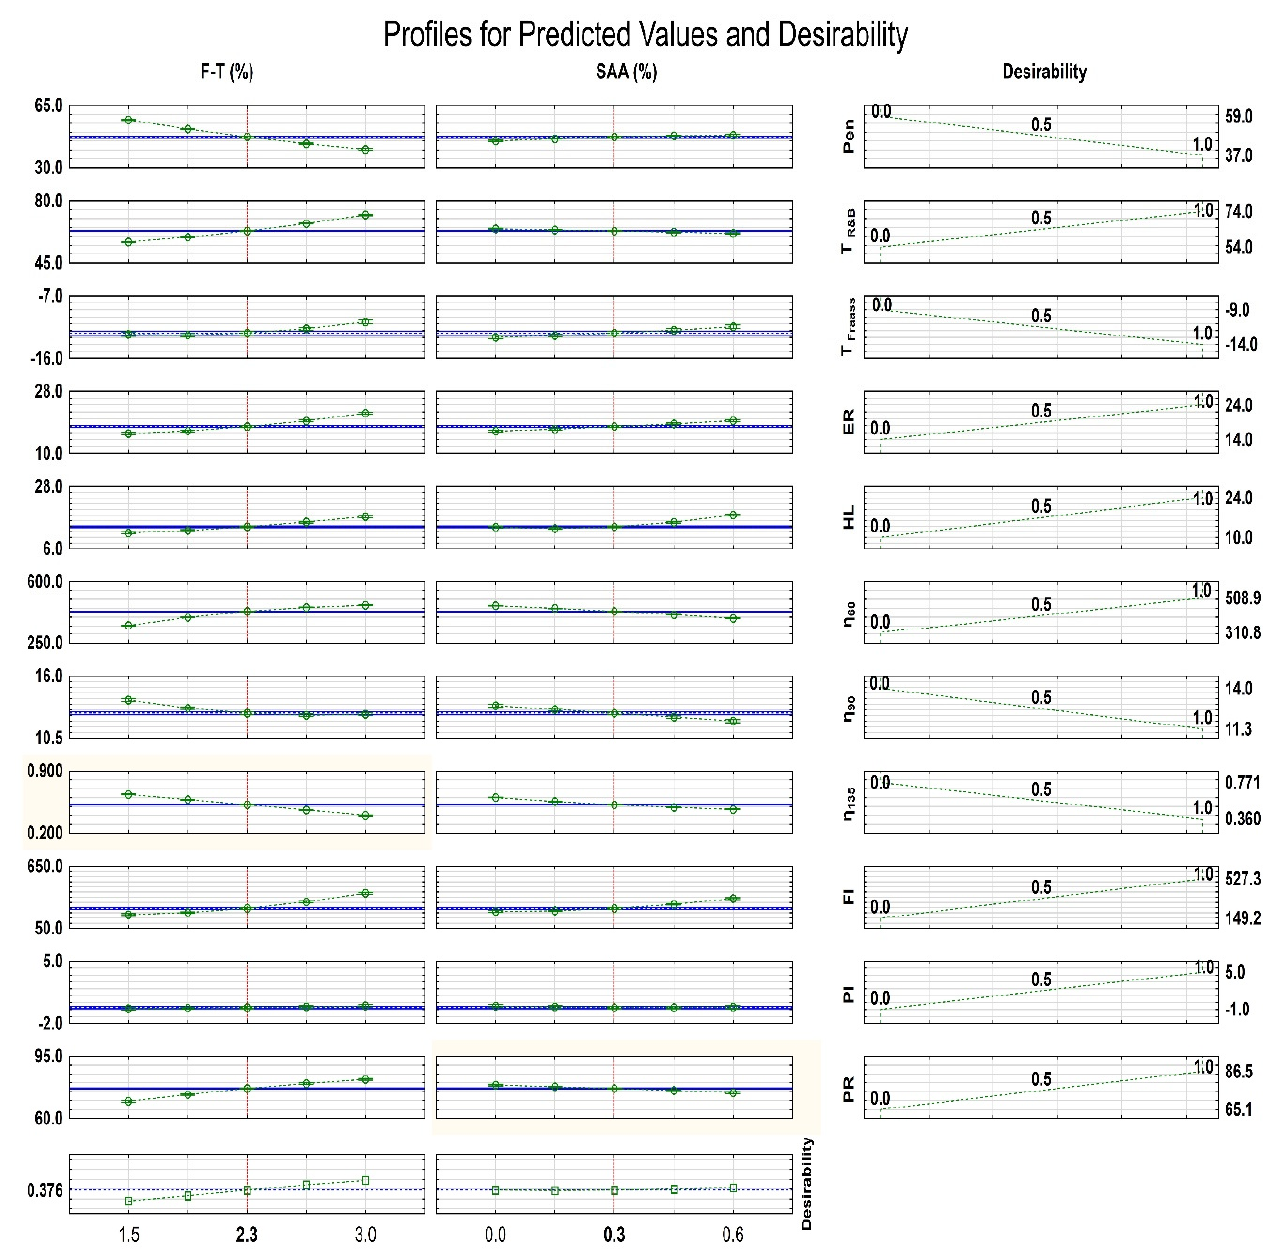
Figure 23. Determining the optimum contents of F–T wax and SAA for optimized properties of bitumen 50/70. The optimization results show that the addition of F–T synthetic wax and SAA had different effects on the assessed properties of the binder in terms of its utility. F–T synthetic wax had a positive effect on the softening point and penetration. A different effect on these parameters was observed when SAA was added. Both chemical additives had a negative effect on the Fraass breaking point, but this effect, as found in detailed analyses, should not be considered very important. The dynamic viscosities measured at 90 ◦ C and 135 ◦ C decreased after the incorporation of both additives in greater amounts, which in turn contributes to the improved coating of aggregate by the binder and more efficient mixture production process. At 60 ◦ C, the addition of F–T synthetic wax increased viscosity, and the effect of SAA was less significant as a decrease was observed. The penetration index after the incorporation of both additives remained constant. The range of plasticity changed after adding the F–T synthetic wax to the binder in the range 1.5% to 2.0%, and a further increase in its concentration did not change it significantly. No significant